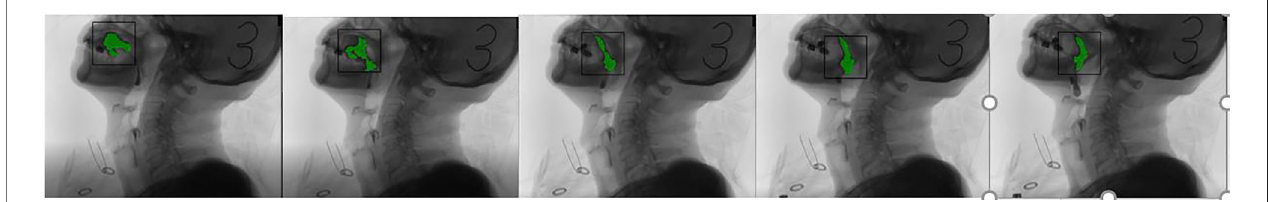
FIGURE 8 | The result of the inter-frame differential method.